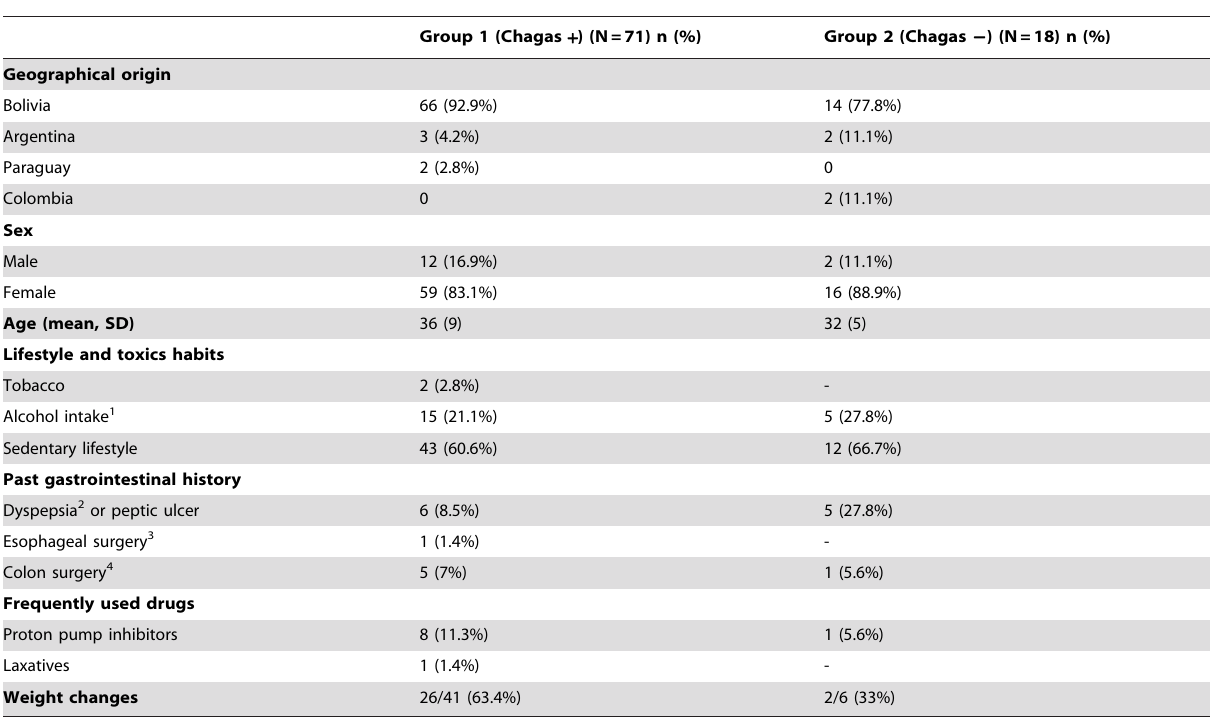
Table 1. Baseline characteristics of patients, including past gastrointestinal history.